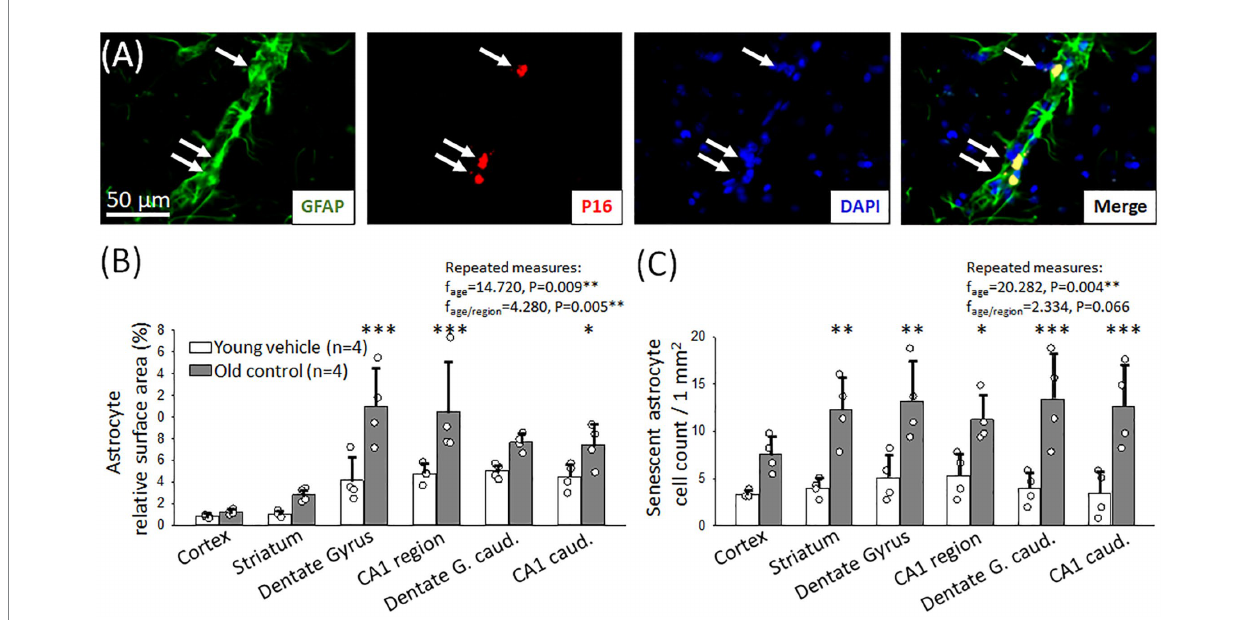
FIGURE 5 Immunocytochemical characterization of astrocyte senescence. (A) Representative fluorescence micrographs of GFAP and p16 co-localization (arrows) in the striatum region of an old animal. GFAP corresponding to astrocyte coverage is shown in green, p16 labeling indicating senescent cells is red; and DAPI illustrates the cell nuclei in blue. (B) Relative area covered by astrocytes labeled with GFAP in different forebrain regions in young and old animals. (C) The number of senescent astrocytes in young and old animals in different brain regions. Individual data points represent the mean value of three sections in each animal. Bar charts show mean ± stdev. The normal distribution of data was evaluated with a Shapiro–Wilk test ( B : p = 0.105, C : p < 0.050-failed). For statistical analysis repeated measures model was used (RM ANOVA), followed by the Holm Sidak post hoc test. Levels of significance were set as p < 0.05*, p < 0.01**, p < 0.001*** vs. Young vehicle.